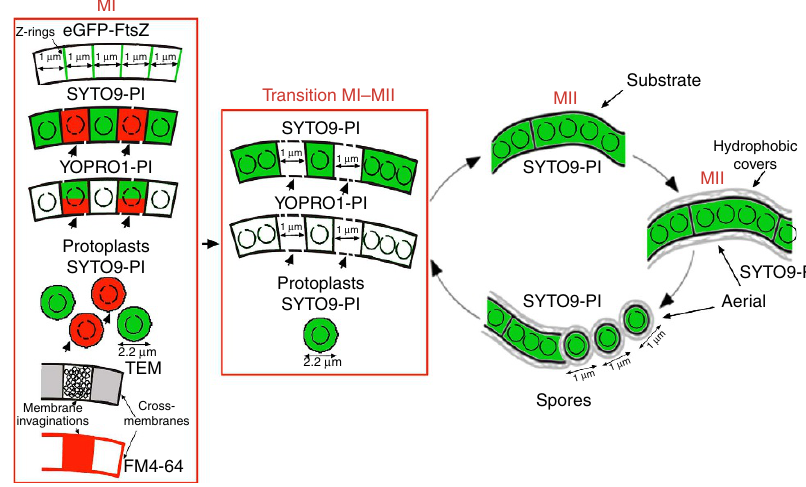
Figure 8 | Model of compartment formation and PCD in vegetative hyphae of Streptomyces coelicolor . Z-rings, cross-membranes, membrane invaginations/vesicles, and protoplasts are illustrated. Peptidoglycan walls (not shown in the scheme) are associated with some of the cross-membranes forming classical septa. Open circles inside compartments represent intact chromosomal DNA, and fragmented circles indicate degraded chromosomal DNA. Membrane discontinuities represent the changes in membrane permeability in dying cells. Red corresponds to PI fluorescence, and green corresponds to SYTO9 or YOPRO1 fluorescence. Arrows indicate dying cells; DNA is fully degraded in these cells during the transition from MI to MII and thus is not stained. FM4-64 labelling is illustrated in